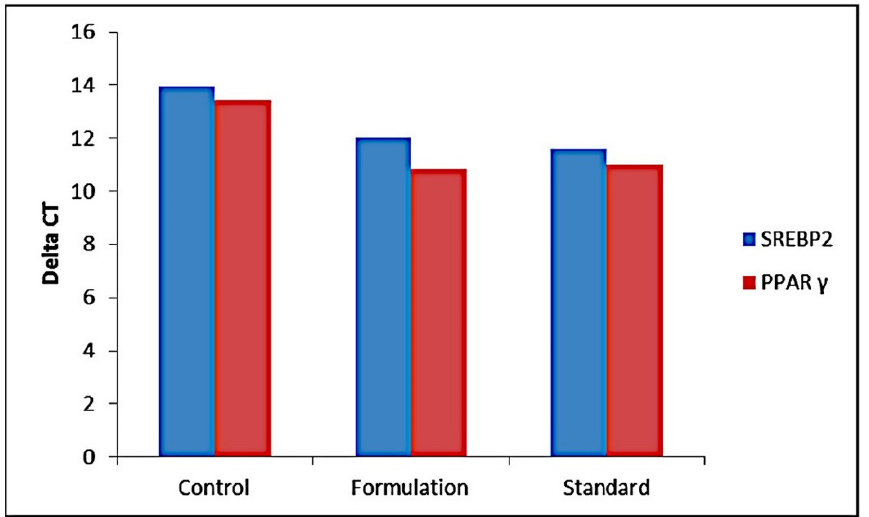
Figure 1. Gene expression study of the standard and CS-SS nanoformulation for transcriptional factors SREBP-2 and PPAR-γ.